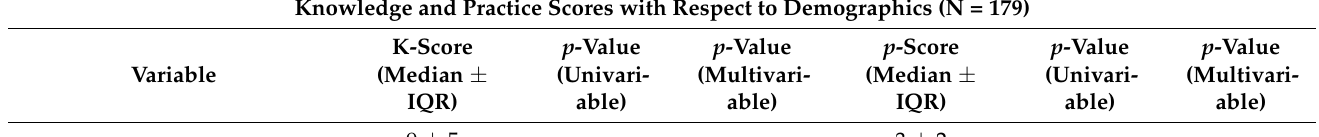
Table 4. Knowledge (K) and practice ( p ) scores with respect to demographics.